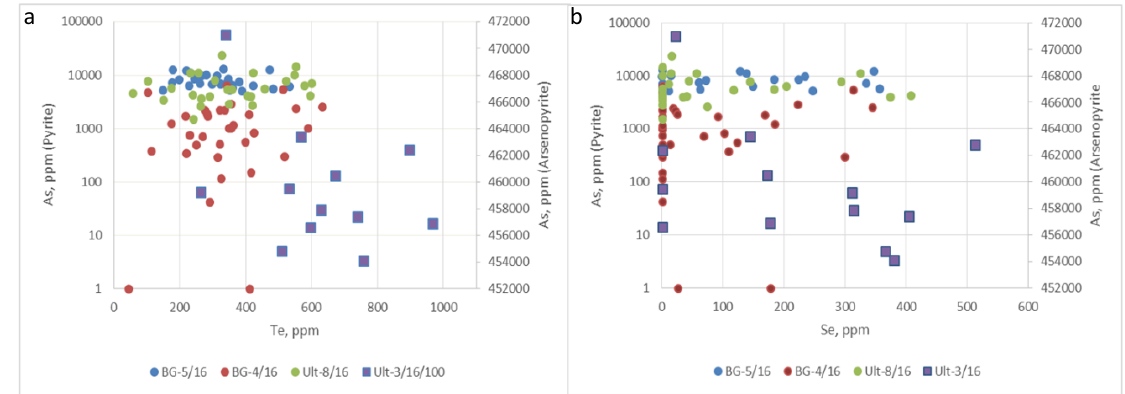
Figure 6. Concentrations of (a) Te and (b) Se vs. As in pyrite (left axis) and arsenopyrite (squares, right axis) from orogenic Au